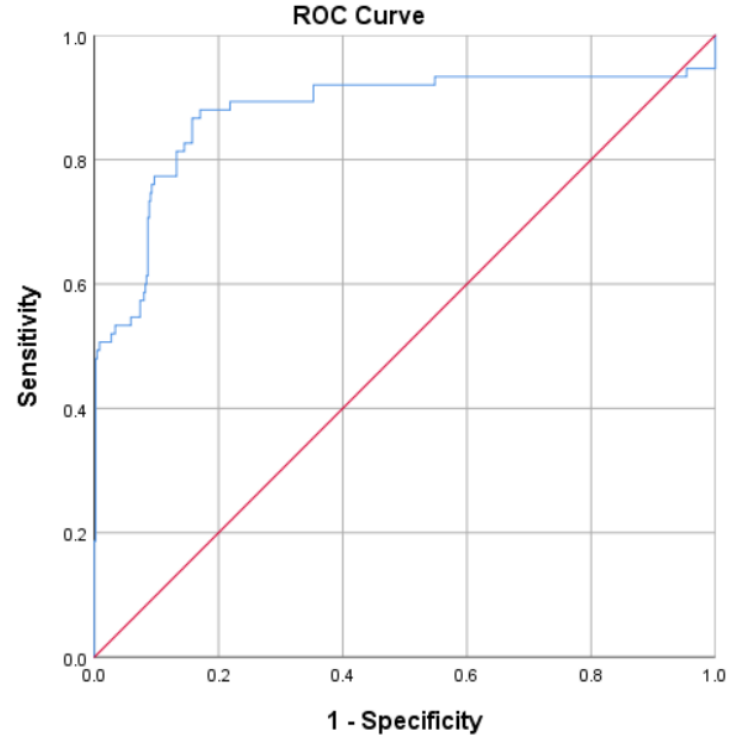
Figure 8. ROC curves of the random forest model.